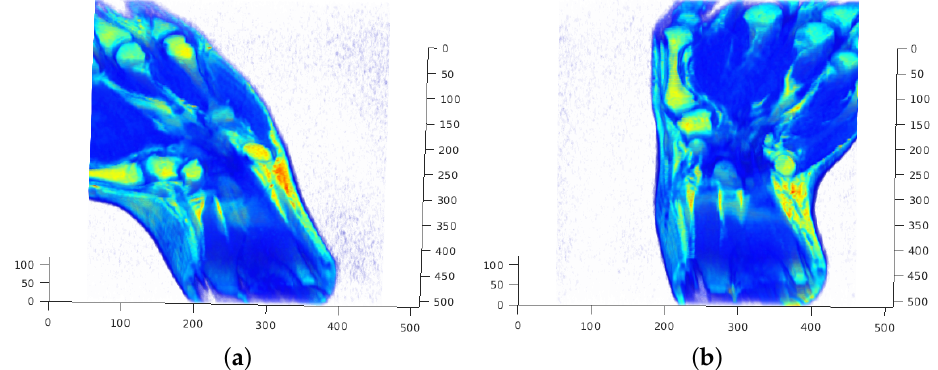
Figure 5. MRT scans of the human hand. Top view of the full voxel images used in the experiments. ( a ) Outer left position of the sequence. ( b ) Outer right position of the